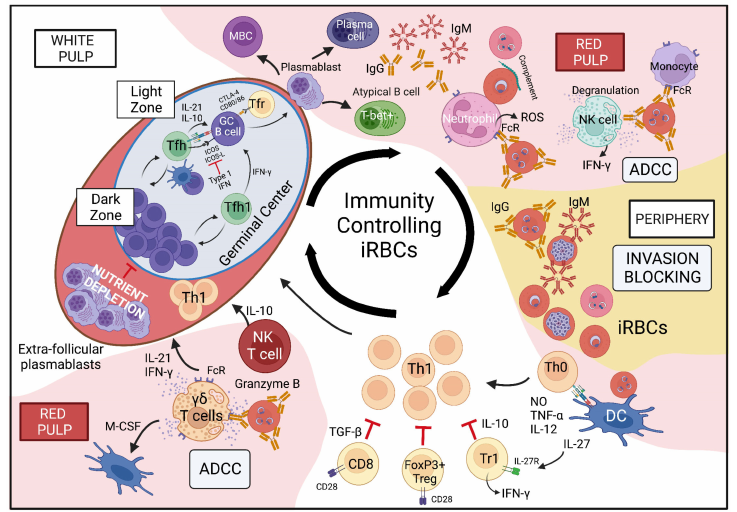
Figure 1. Contribution of mechanisms influencing immune control to Plasmodium -infected red blood cells. Mouse models of malaria have been used to demonstrate how innate and adaptive immune mechanisms synergize to effectuate control of iRBCs. In the white pulp of the spleen activation of T helper cells including Th1 cells, Tfh cells and regulatory cells (both Treg cells and Tr1 cells) are activated by antigen presenting cells which have phagocytosed iRBCs by-products of parasite development that are released during schizogony. Tfh cells are critical in providing help to B cells